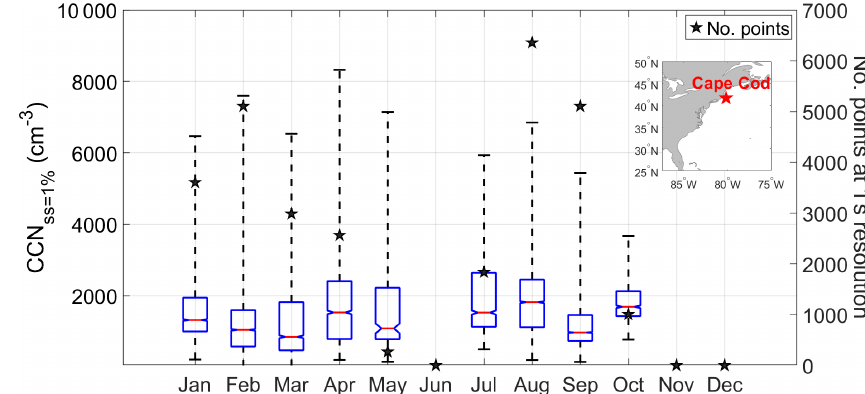
Figure 5. Monthly statistics of CCN concentration (1% supersaturation) measured at Cape Cod between July 2012 and May 2013. Red lines represent the median, whiskers are the monthly range, and the top and bottom of the boxes represent the 75th and 25th percentiles, respectively. The notches in the box plots demonstrate whether medians are different from each other with 95% confidence. Boxes with notches that do not overlap with each other have different medians with 95%